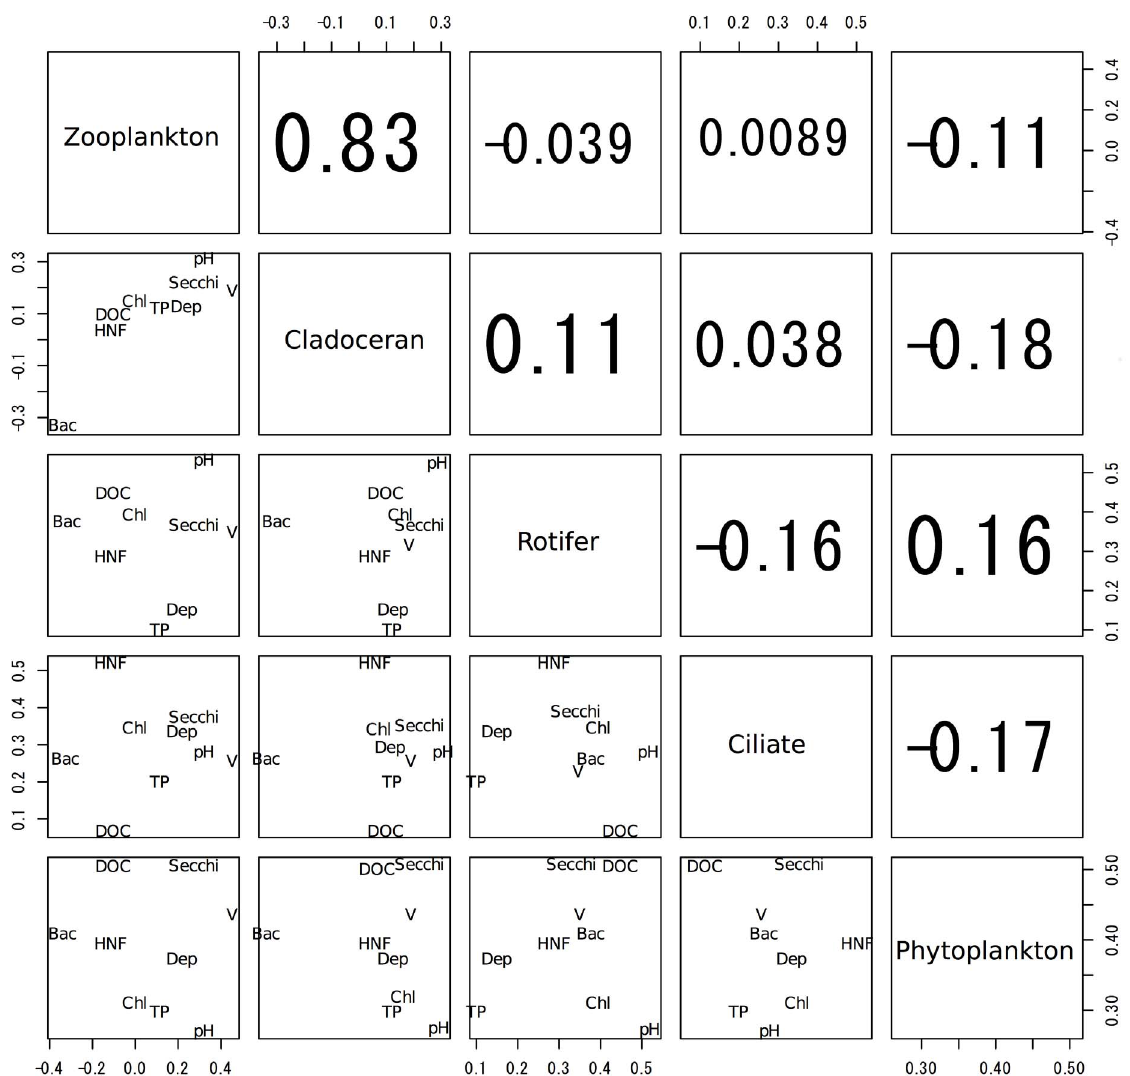
Figure 3. Correlation between planktonic groups based on mean absolute scores of environmental factors. Graph showing the correlation between the planktonic groups based on the absolute scores of the environmental factors used in the canonical correspondence analysis axes 1–3. Each plot represents the absolute score of the environmental factors. TP, total phosphorus; DOC, dissolved organic carbon in water; Chl, chlorophyll a ; HNF, heterotrophic nanoflagellates; Bac, number of bacteria cells; V, pond volume; Dep, mean water depth. The numbers in the upper right-hand columns denote Pearson’s correlation coefficients. All coefficients were non-significant ( p . 0.05).